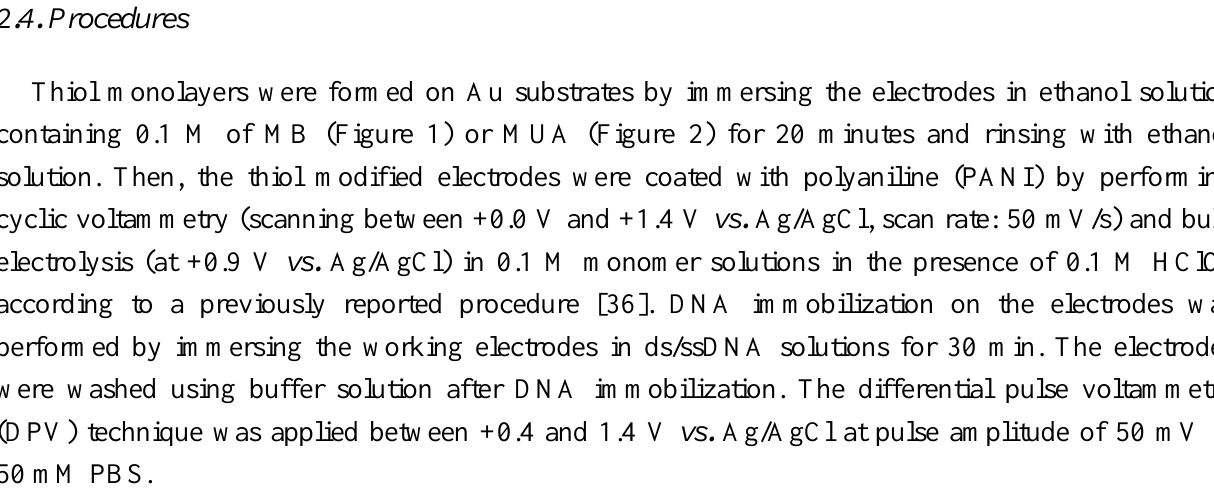
Figure 2. 11-Mercaptoundecanoic acid